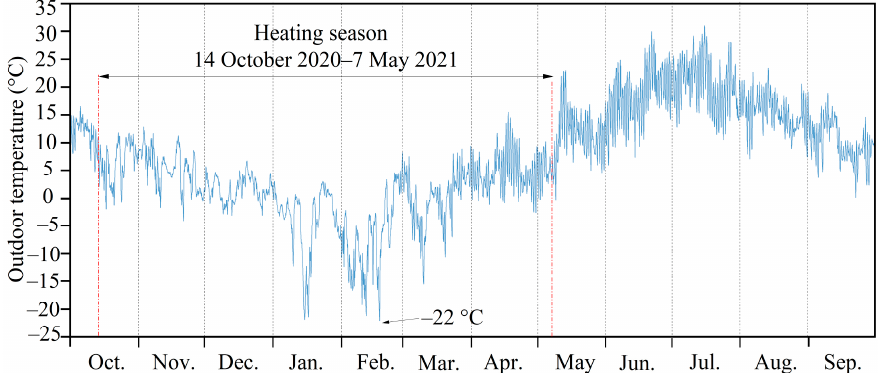
Figure 6. Outdoor temperature from October 2020–September 2021 in Espoo.